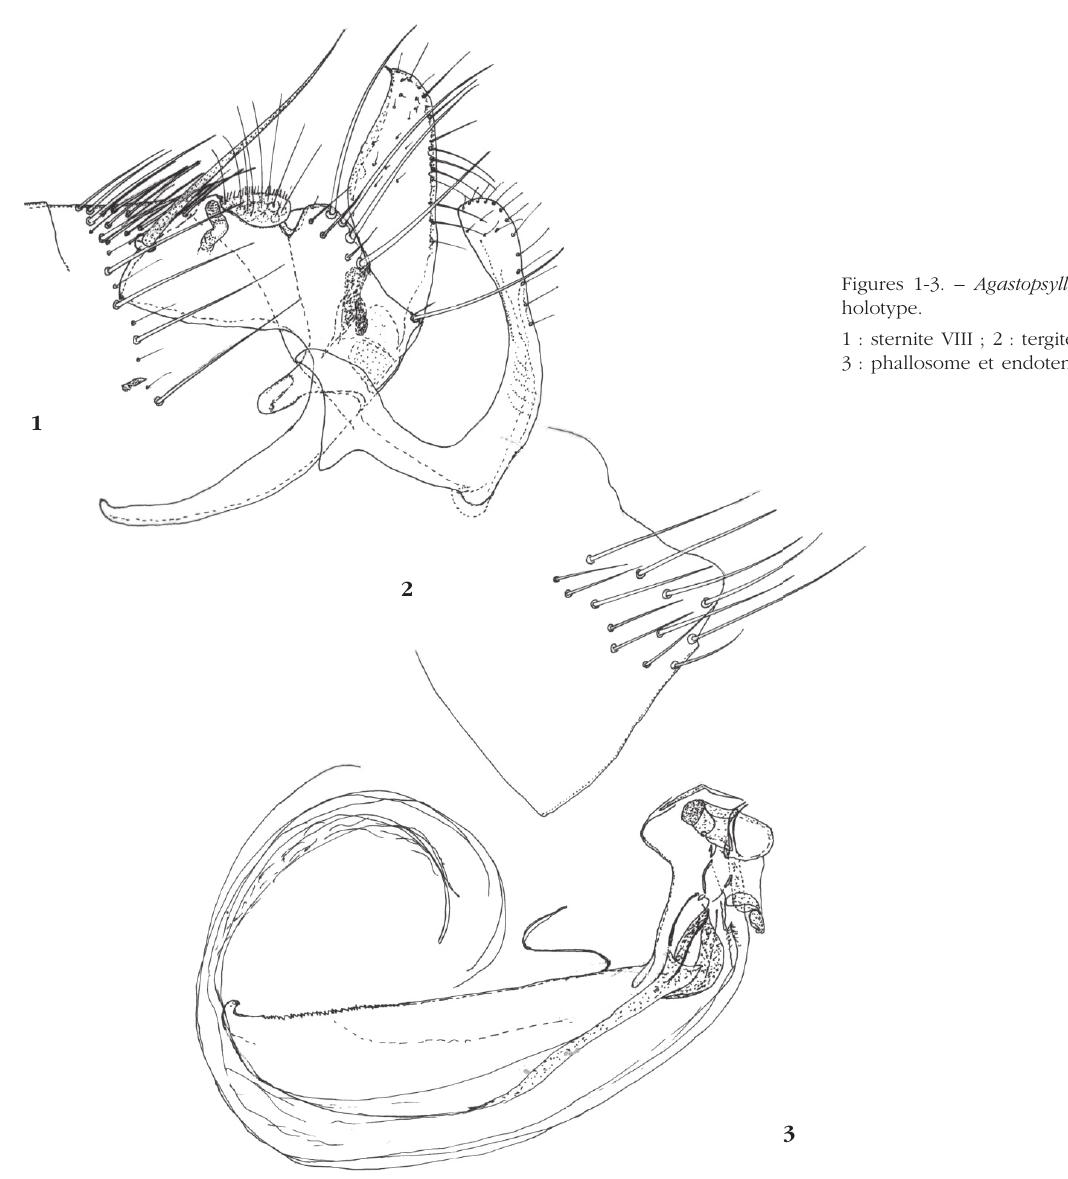
Figures 1-3. – Agastopsylla guzmani n. sp.,